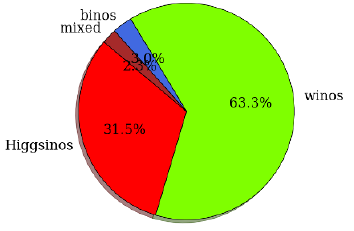
Figure 16 . Fractions of neutralino 1 types in our scan after imposing the light Higgs mass limit, LEP and (cid:13)avour constraints, and relic density upper